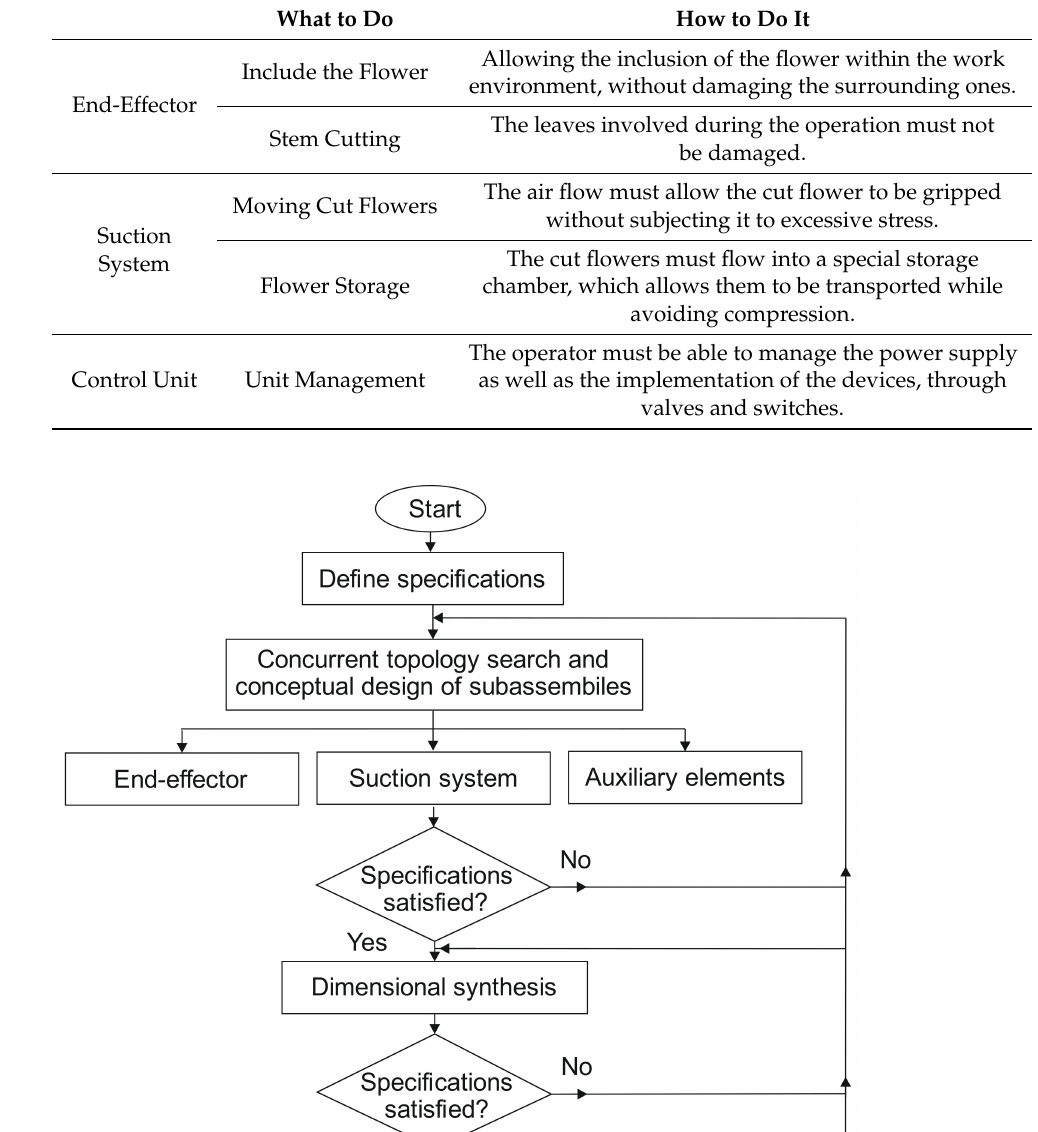
Table 1. Functional analysis of the proposed device.